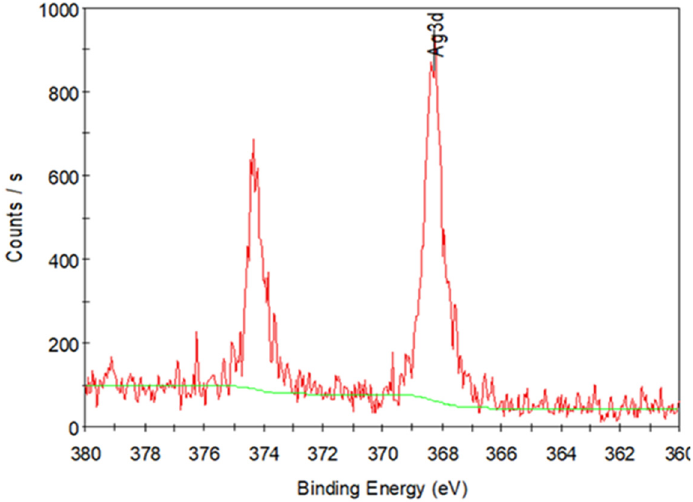
Figure 12. XPS spectra of the residue obtained after the TG analysis of the PVP/Ag NP fibers (5 MPa and applied voltage of 15 kV).